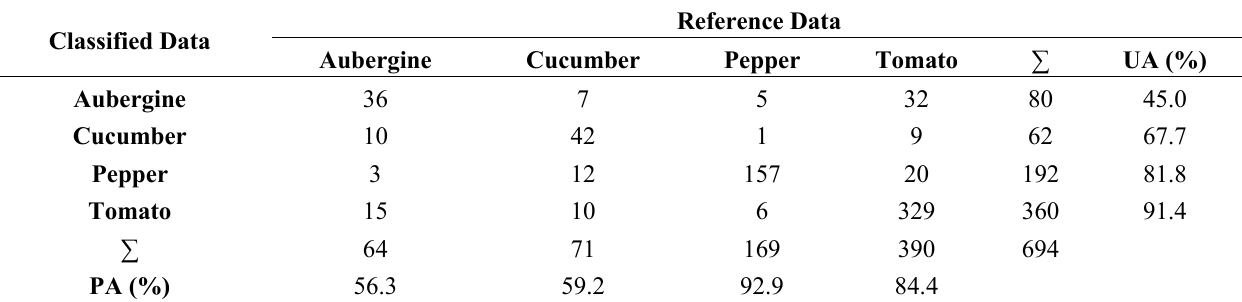
Table 5. Confusion matrix for Landsat 8 time series dataset and no GLCM strategy. PA, producer’s accuracy.